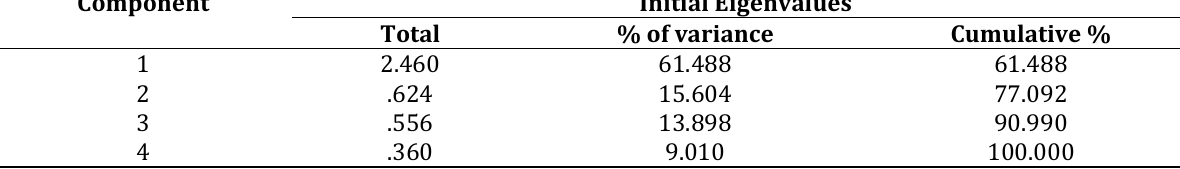
Table 10: Results of Eigen analysis of covariance matrix of the IOT variables